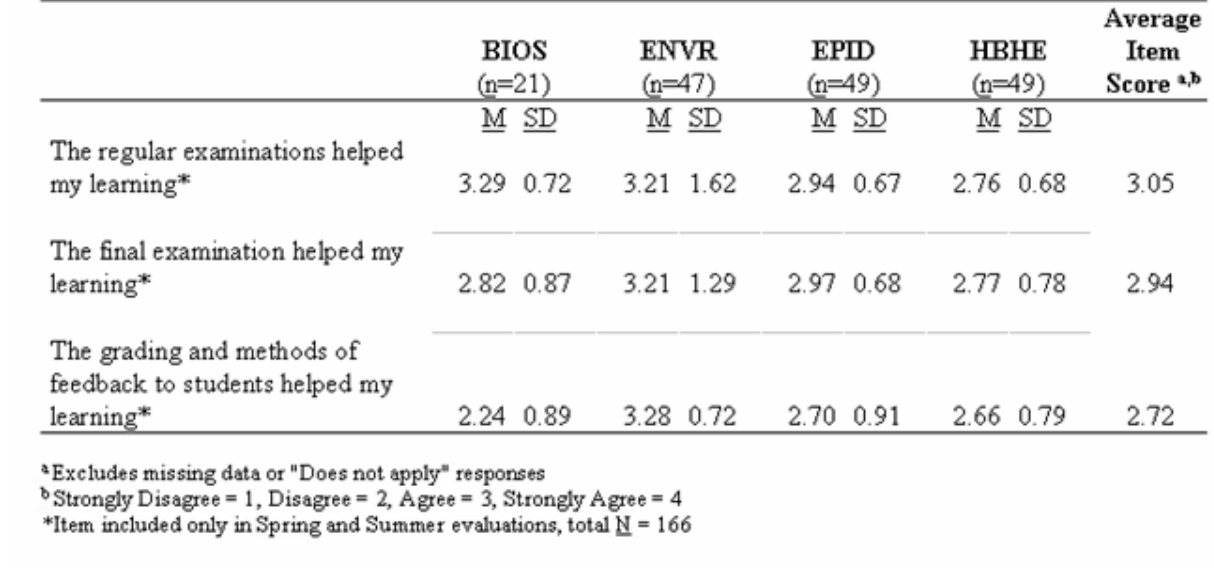
Table 6. Students' General Satisfaction with the